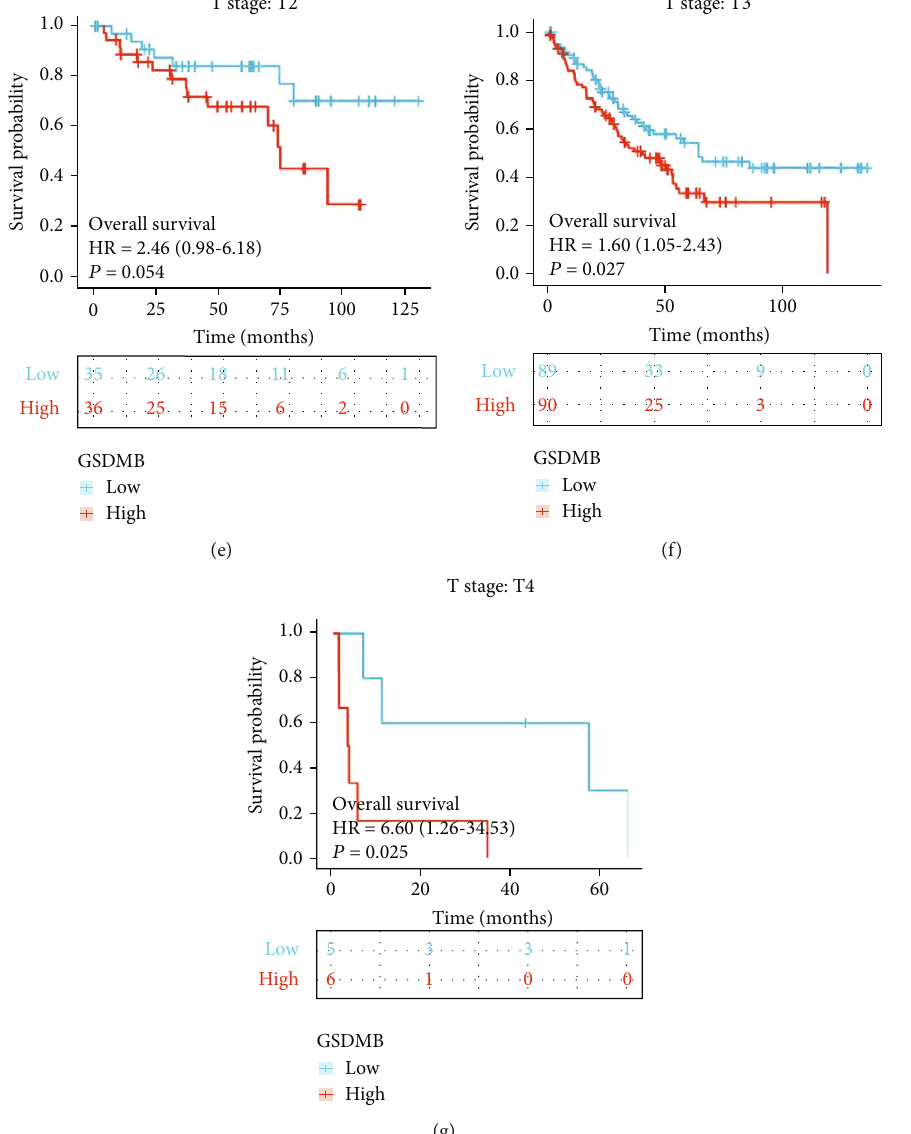
Figure 4: ROC and Kaplan-Meier curves for GSDMB. (a) ROC curve showed that GSDMB had an AUC value of 0.820 to discriminate ccRCC tissues from healthy controls. (b, c) Kaplan-Meier survival curves indicated that ccRCC patients with high GSDMB mRNA expression had a shorter OS and DSS than those with low-level of GSDMB. Besides, a subgroup analysis was performed on T1, T2, T3, and T4, respectively (d – g). It showed that GSDMB correlates with high T stage and unfavourable prognosis. OS: overall survival; DSS: disease-speci fi c